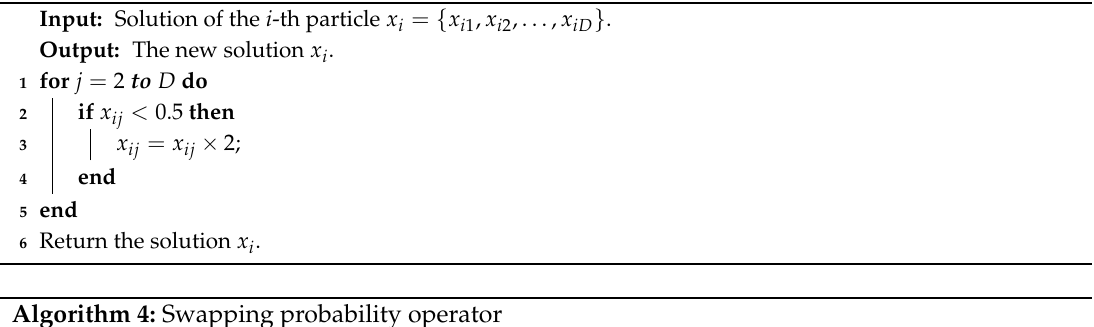
Algorithm 4: Swapping probability operator